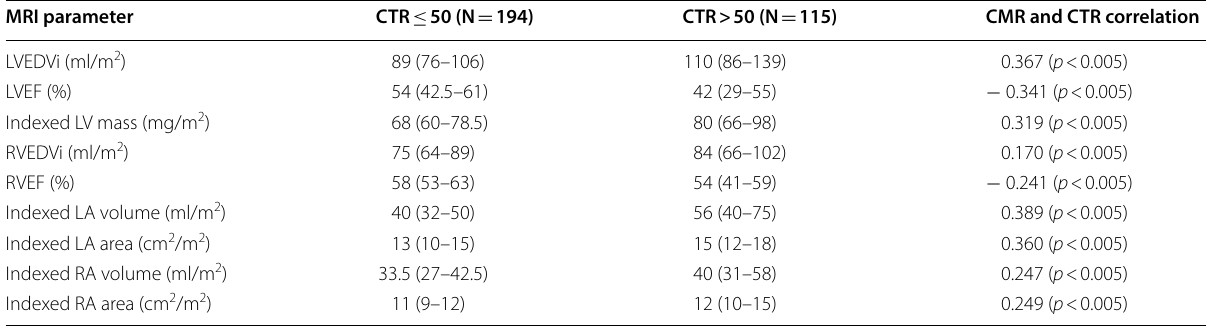
Values in the two middle columns are median (interquartile range), and values in the far-right column are correlation coefficients MRI magnetic resonance imaging, CTR cardiothoracic ratio, LVEDVi left ventricular indexed end-diastolic volume, LVEF left ventricular ejection fraction, LV left ventricle, RVEDVi right ventricular indexed end-diastolic volume, RVEF right ventricular ejection fraction, LA left atrium, RA right atrium